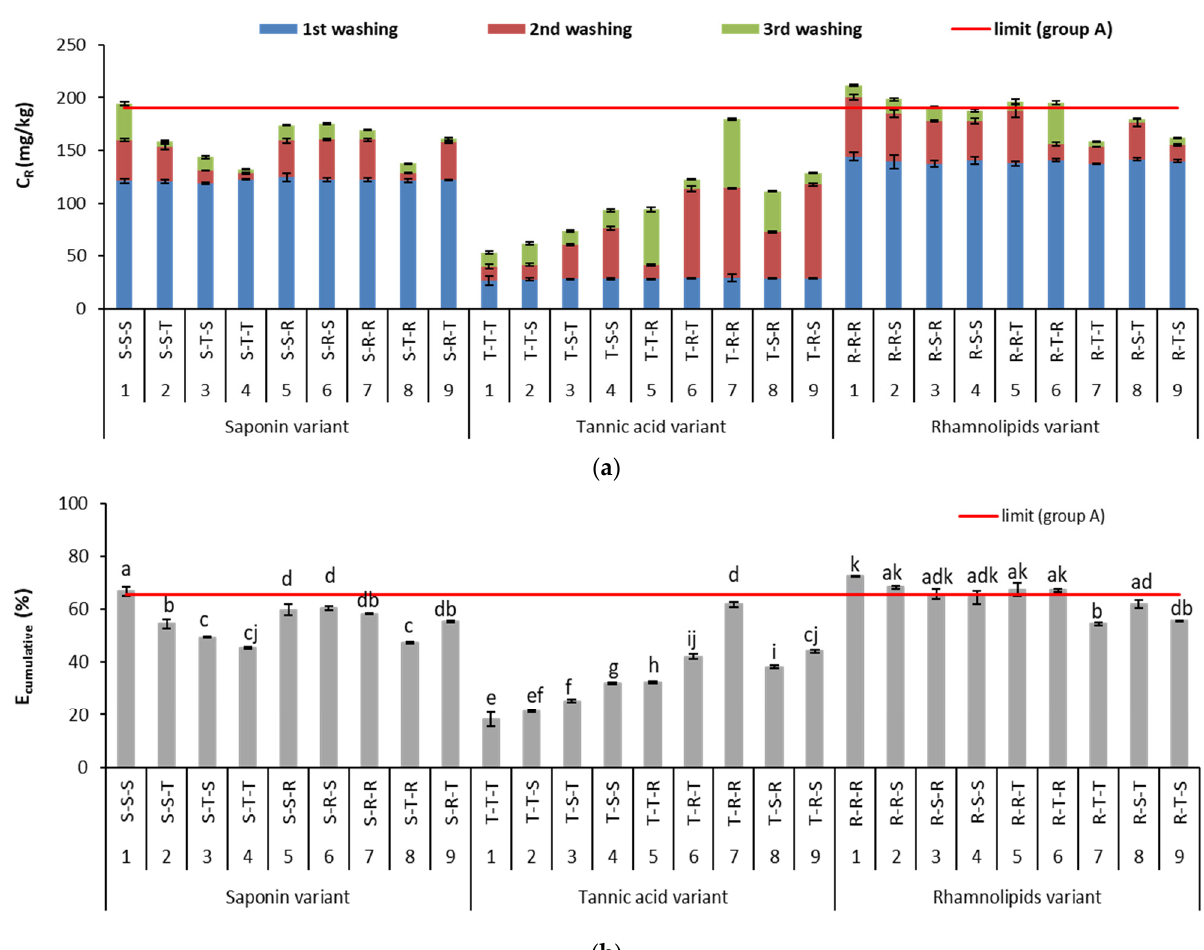
Figure 4. Concentration of metal removed (C R ) ( a ) and cumulative efficiency of Pb removal (E cumulative ) ( b ) during sequential soil washing. For E cumulative , different letters indicate significant differences in metal removal efficiency with different biosurfactant sequences ( p < 0.05). Limit (group A) means minimum Pb concentration to be removed from soil or minimum Pb removal efficiency to meet limit value for agricultural area.